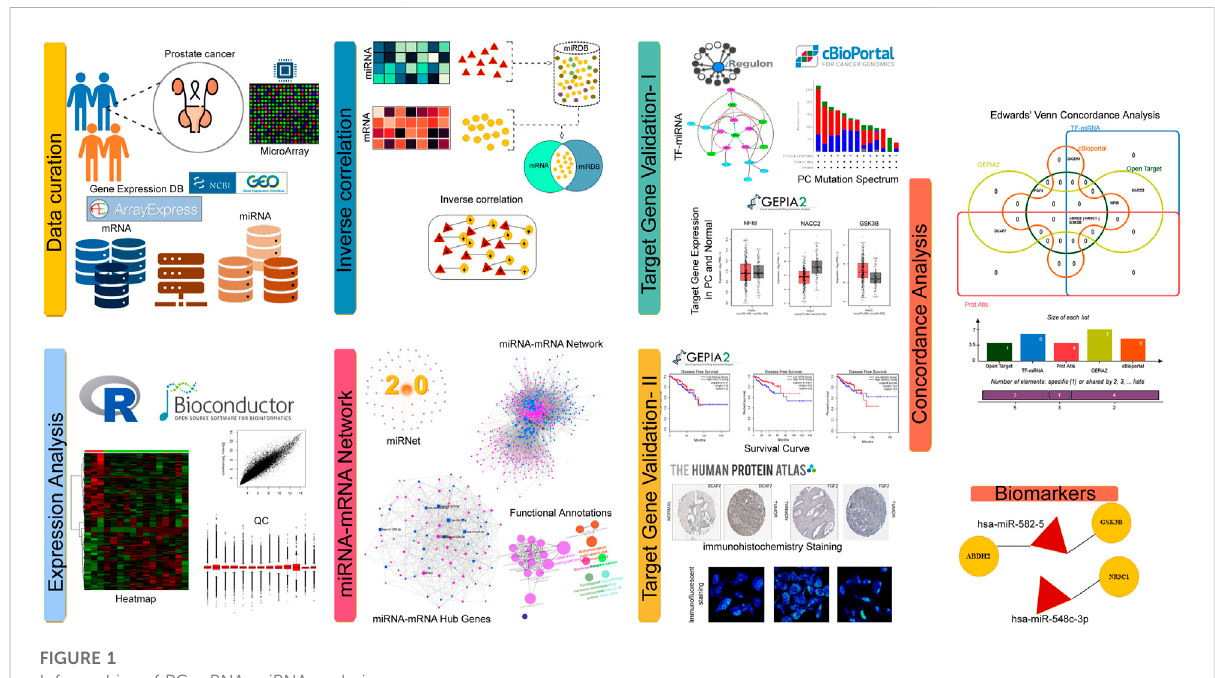
FIGURE 1 Infographics of PC mRNA-miRNA